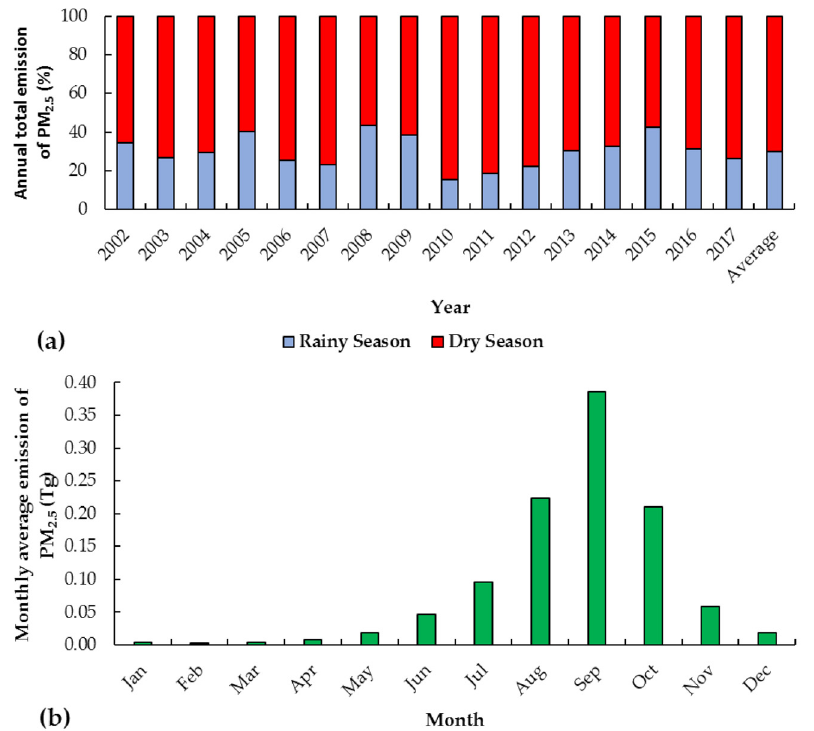
Figure 3. ( a ) Percentage of PM 2.5 fire emissions in the dry (May to September) and rainy (October to April) seasons of the Cerrado during the 2002–2017 period and ( b ) Monthly average emission of PM 2.5 associated with fires in the Cerrado. Estimates were obtained while using PREP-CHEM-SRC 1.8.3.